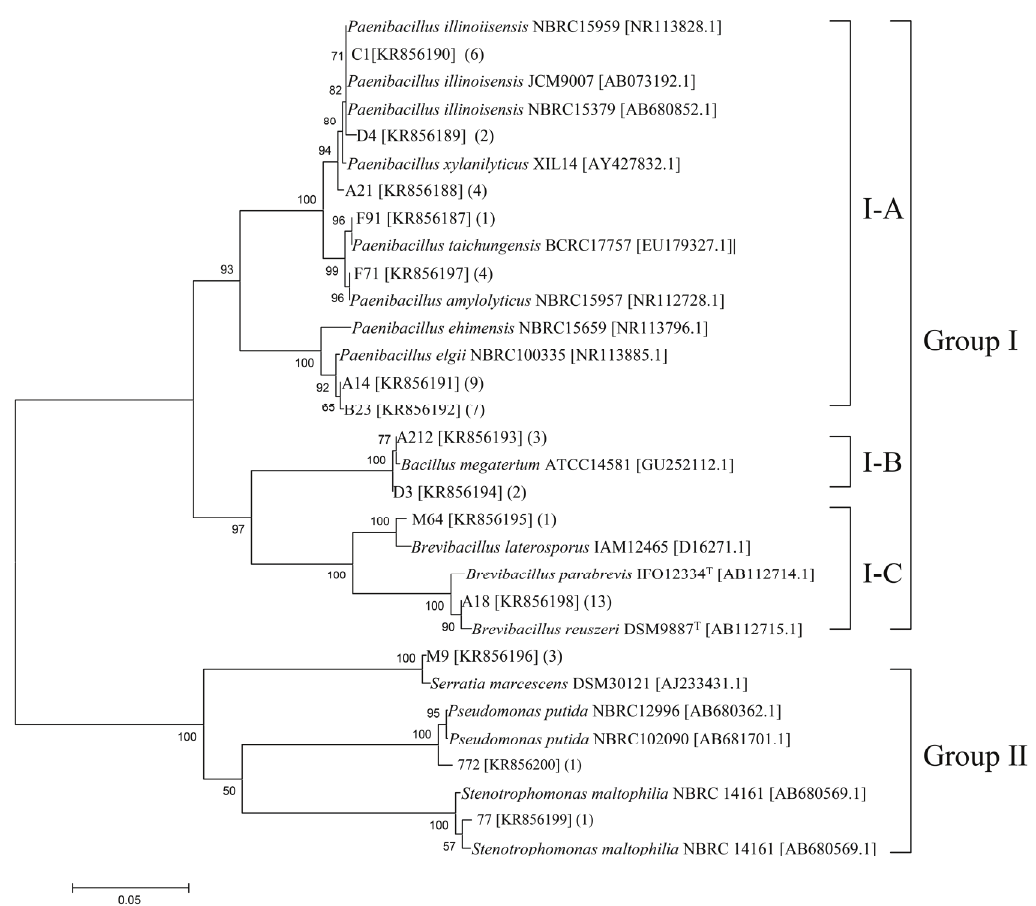
Figure 1. Phylogenetic relationship of the representative chitinolytic bacteria isolated from the wetland based on the aligned sequences of the 16S rRNA gene. Numbers above each node indicate percentage of confidence levels generated from 1000 bootstrap trees. The number of isolates with the same 16S rRNA gene is shown in